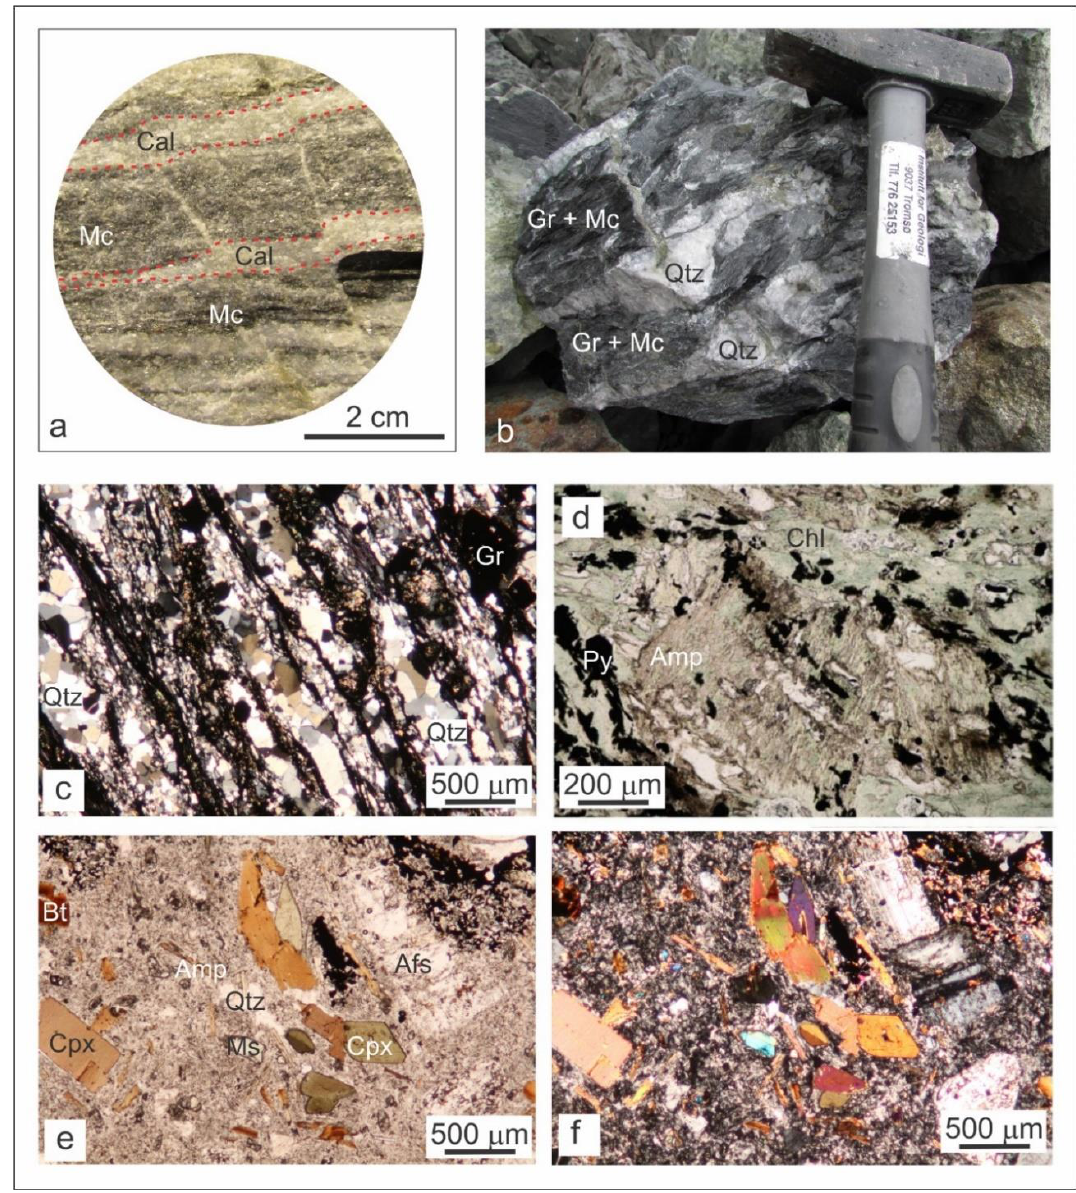
Figure 3. ( a ) Cross-cut section of a core drilled through cipollino marble; ( b ) Hand specimen of quartz – graphite schist; ( c ) Transmitted light photomicrograph of quartz – graphite schist (cross polars); ( d ) Transmitted light photomicrograph of Precambrian gneiss (plane polarized light); ( e ) Transmitted light photomicrograph of trachyte associated with the Sasa Pb-Zn-Ag mineralization (plane polarized light); ( f ) Transmitted light photomicrograph of trachyte associated with the Sasa Pb-Zn-Ag mineralization (crossed polars). Abbreviations: Cal — calcite; Mc — mica; Qtz — quartz; Gr — graphite; Amp — amphiboles; Chl — chlorites; Py — pyrite; Cpx — clinopyroxene; Bt — biotite; Ms — muscovite; Afs — alkali feldspars.